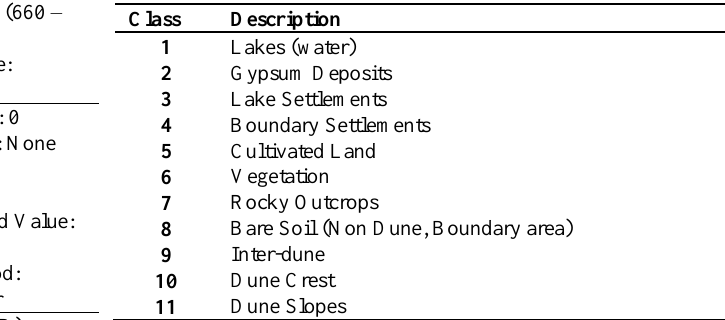
Table 4: Training Sample